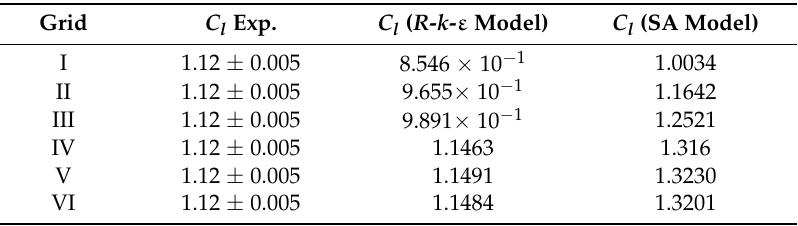
Table 5. Lift coefficient values for the NACA 0015 airfoil at α = 12°, δ = 0° and Re = 10 6 using RANS models.